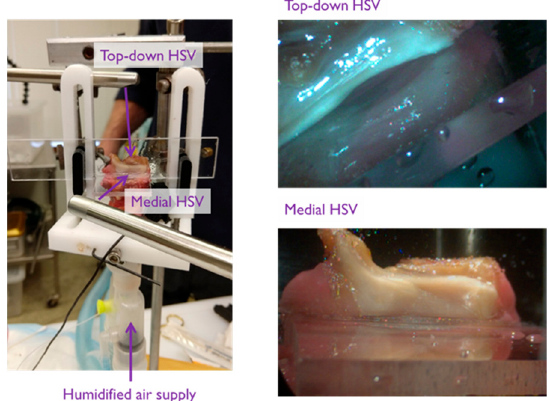
Figure 5. Hemilarynx preparation with two rigid endoscopes simultaneously visualizing the superior (top–down) and medial (en face) vocal fold surface using synchronized high-speed video (HSV) cameras.